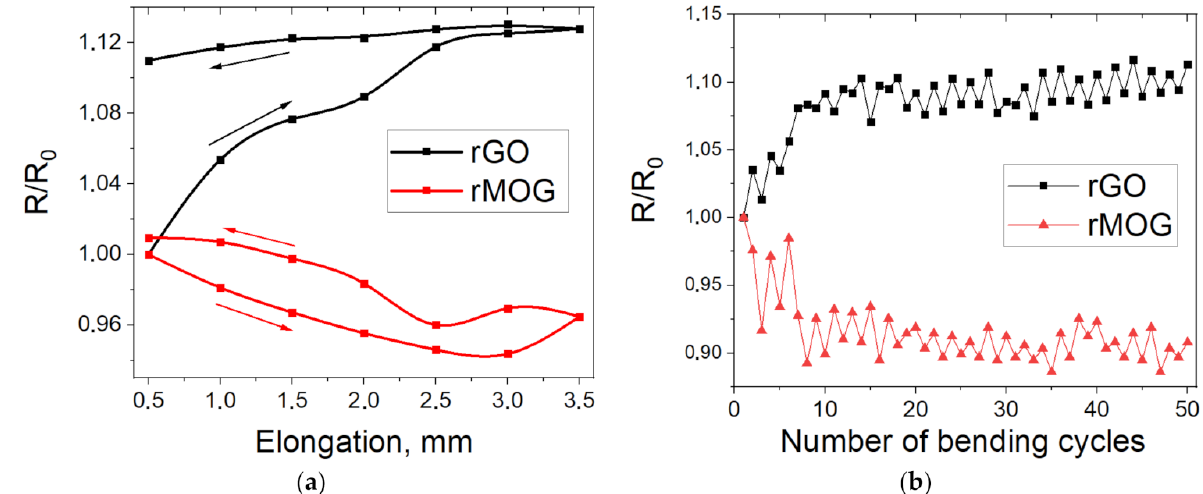
Figure 9. Changes in electrical resistance of rGO and rMOG e-textiles: ( a ) changes from elongation and subsequent relaxation; ( b ) changes from the number of bending